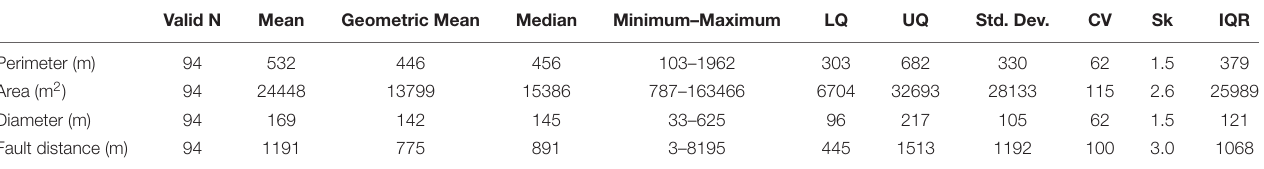
TABLE 1 | Summary of the statistical analyses of main measured variables of CS in the studied area. Valid N Mean Geometric